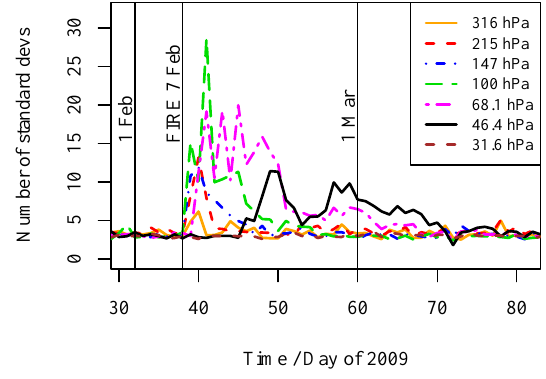
Fig. 4. Mean number of standard deviations above the mean CO mixing ratio for the points identified as unusual in Fig. 3.